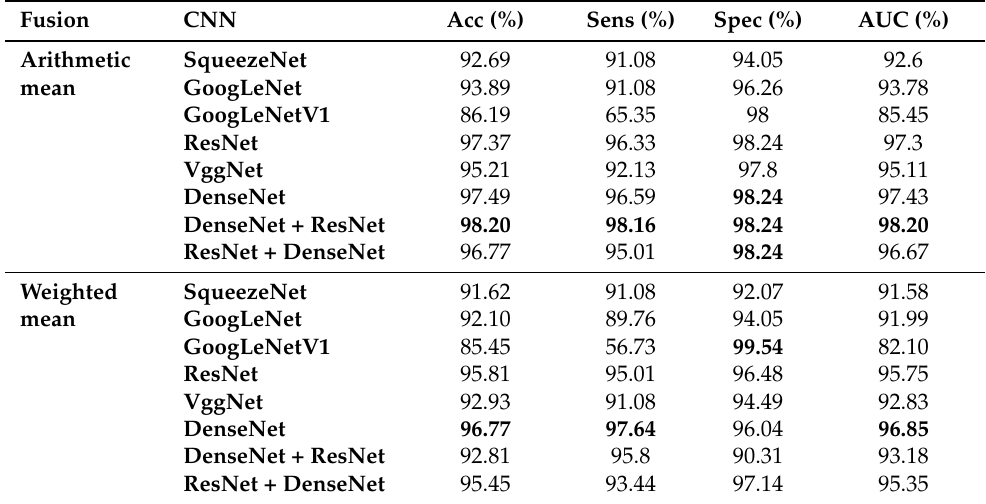
Table 5. The values of the classification performance parameters for CNNs when performing decision level fusion.